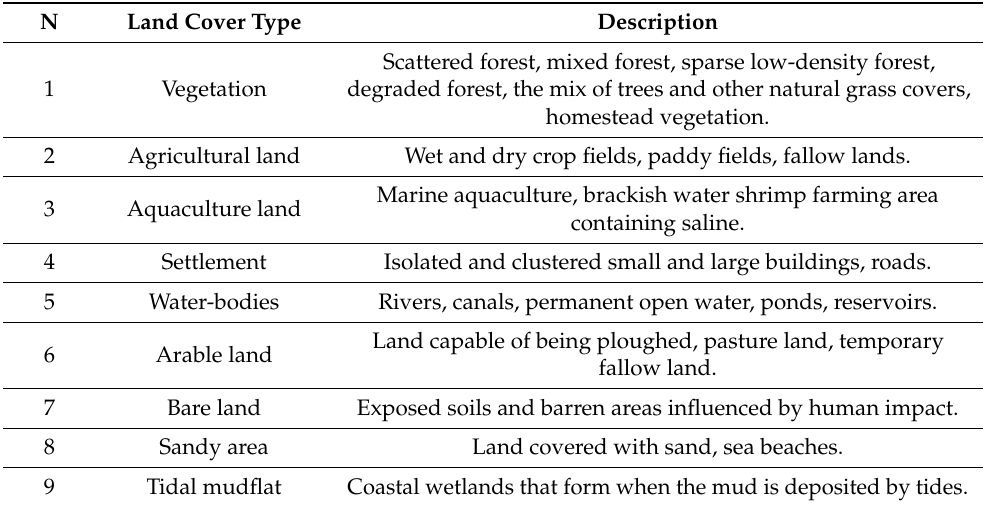
Table 2. Land use/land cover (LULC) classes delineated based on supervised classification (based on